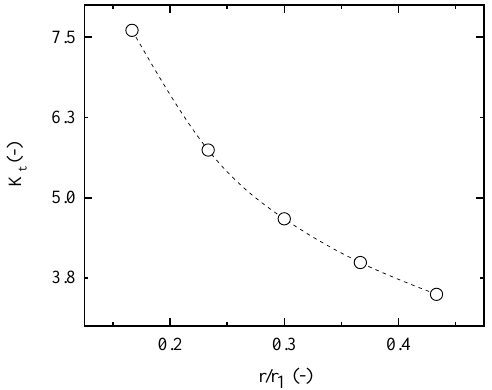
Figure 13. Stress concentration factor ( Kt ) decreases with the increase in elliptical channel radius. Stress intensity also slightly changes with the increase in additional elliptical channel